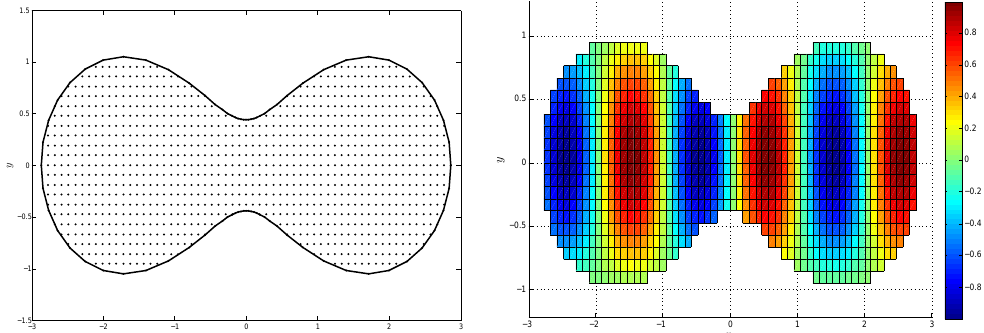
Figure 7. Computational domain x -axis [ − 3,3 ] and y -axis [ − 3,3 ] ( left ) and numerical solution ( right ) for Problem